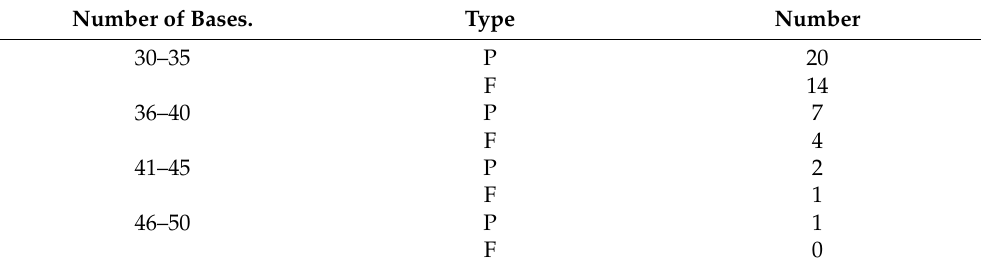
Table 2. Repetitive sequences detected in the Trebouxiophyceae sp. DW1 chloroplast genome using the REPuter. Number of